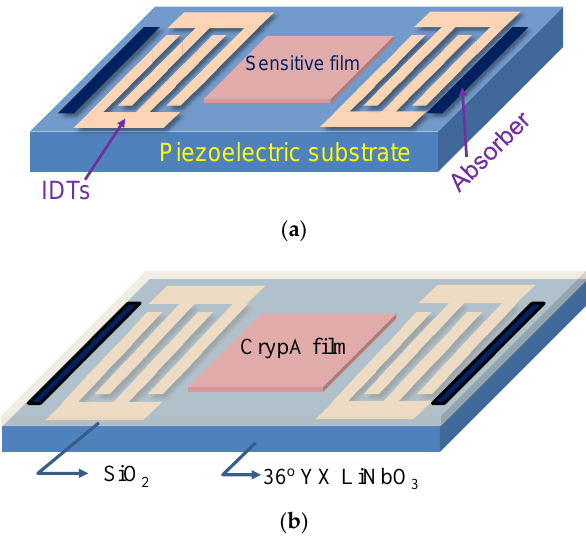
Figure 1. The schematic of SAW based gas sensor ( a ) and Love wave based sensor ( b ).